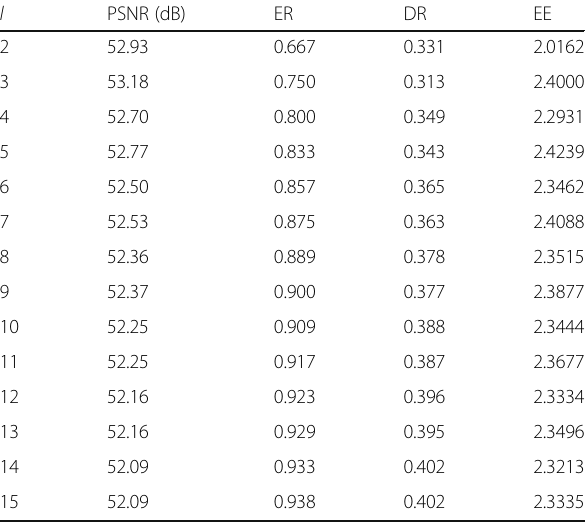
Table 1 Performance of HPSB algorithm with different block length l